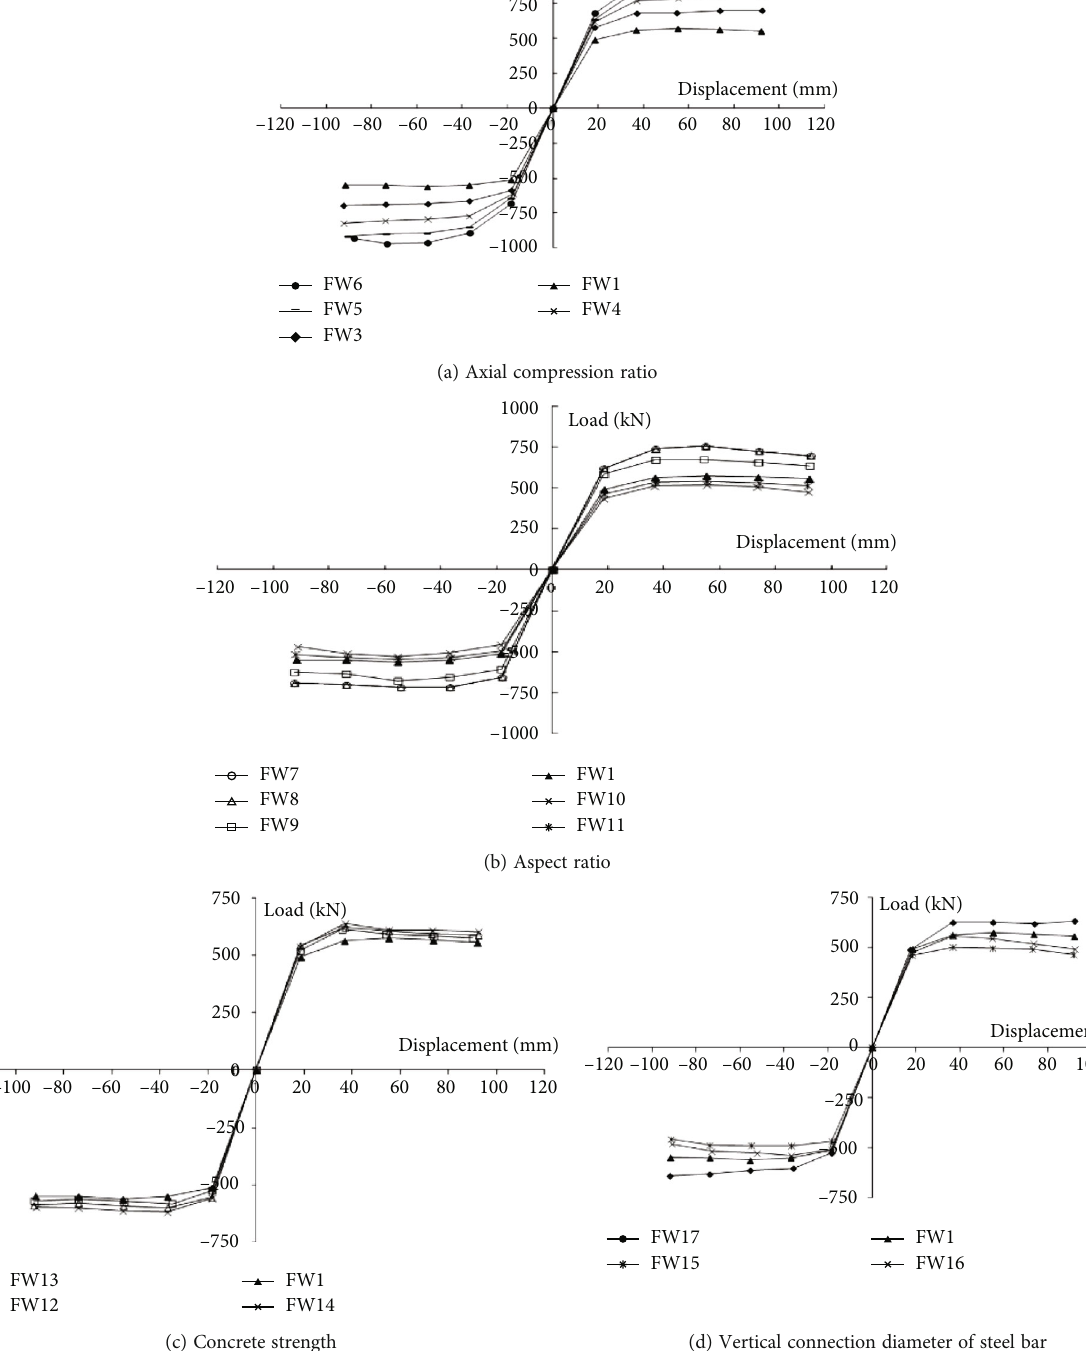
Figure 13: Load-displacement curve of each